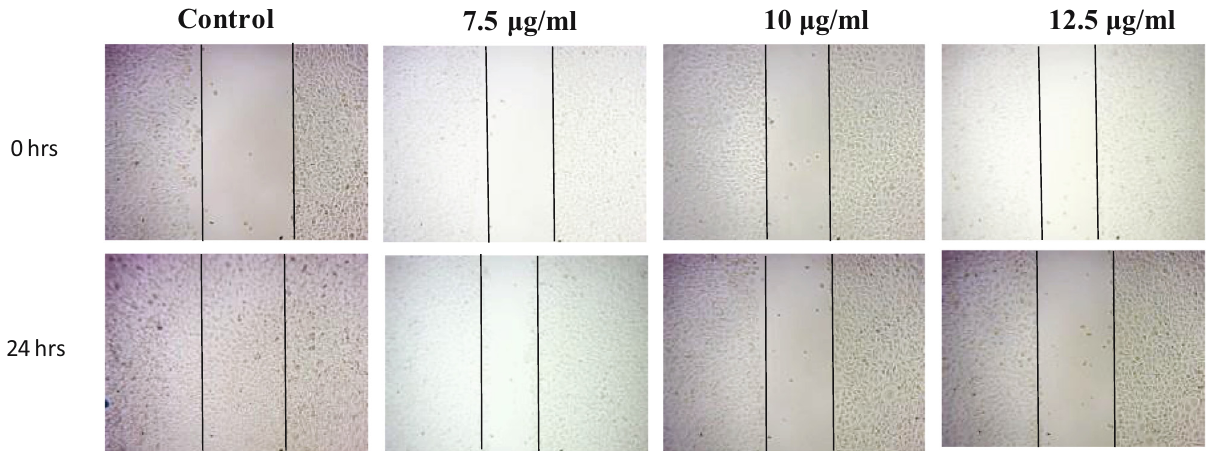
Figure 11: E ff ect of ZnO NPs on cell migration in MDA - MB - 231 cells.